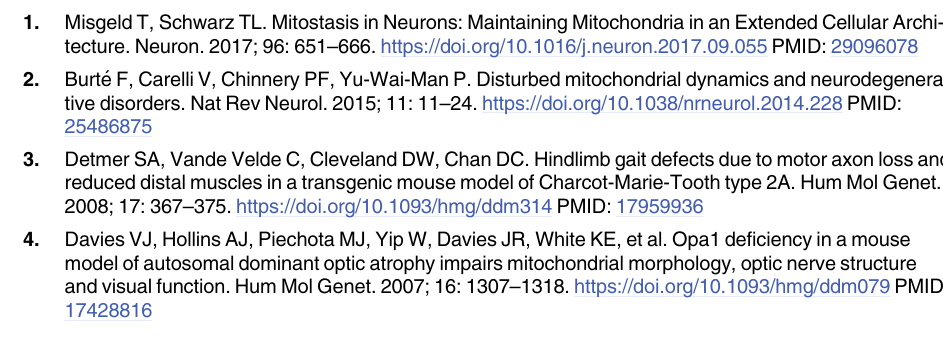
mutants ( drp1 2 /drp1 KG ) which co-express mitoGFP (cyan) and the indicated RNAi driven by the pan-motoneuron driver D42-Gal4. Tissue was stained for autophagy receptor Ref(2)p (red) and mitochondrial IMM protein ATP5A (yellow). The dashed box outlines a single Gal4-expressing neuronal cell body that is shown in high magnification in the inset. Arrow- heads highlight example mitophagy intermediates (Ref(2)p+/ATP5A+). In the inset of drp1 mutant expressing Atg5 RNAi (bottom), open arrowheads highlight mitophagy intermediates that contain mitoGFP, while the closed arrowheads highlight mitophagy intermediates that lack mitoGFP. Scale bars = 10 μ m, 2 μ